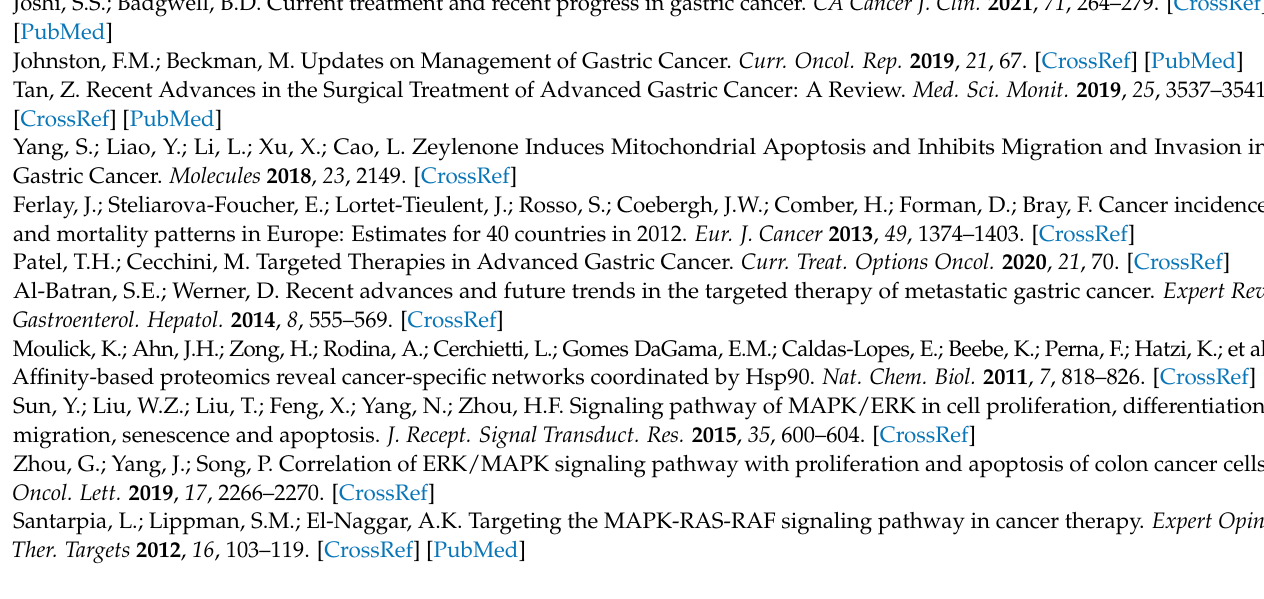
MGC803 cells ( n = 3), Figure S5: Original western blots images of p-ERK and Bad in MGC803 cells ( n = 3), Figure S6: Original western blots images of Ras in MGC803 cells ( n = 3), Figure S7: Original western blots images of ERK, Bcl-xl and Bax in SGC7901 cells ( n = 3), Figure S8: Original western blots images of p-c-Raf and Ras in SGC7901 cells ( n = 3), Figure S9: Original western blots images of p-ERK in SGC7901 cells ( n = 3), Figure S10: Original western blots images of Bad in SGC7901 cells ( n = 3), Figure S11: Original western blots images of Cyclin B1 in SGC7901 cells ( n = 3), Figure S12: Original western blots images of MMP9 in SGC7901 cells ( n =